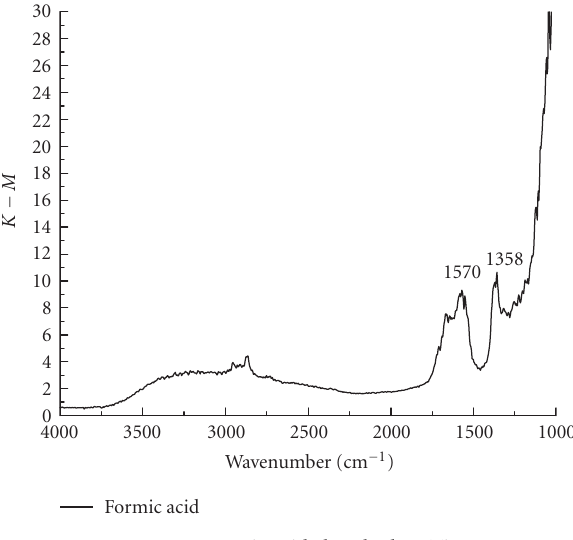
Figure 10: Formic acid absorbed on TiO 2